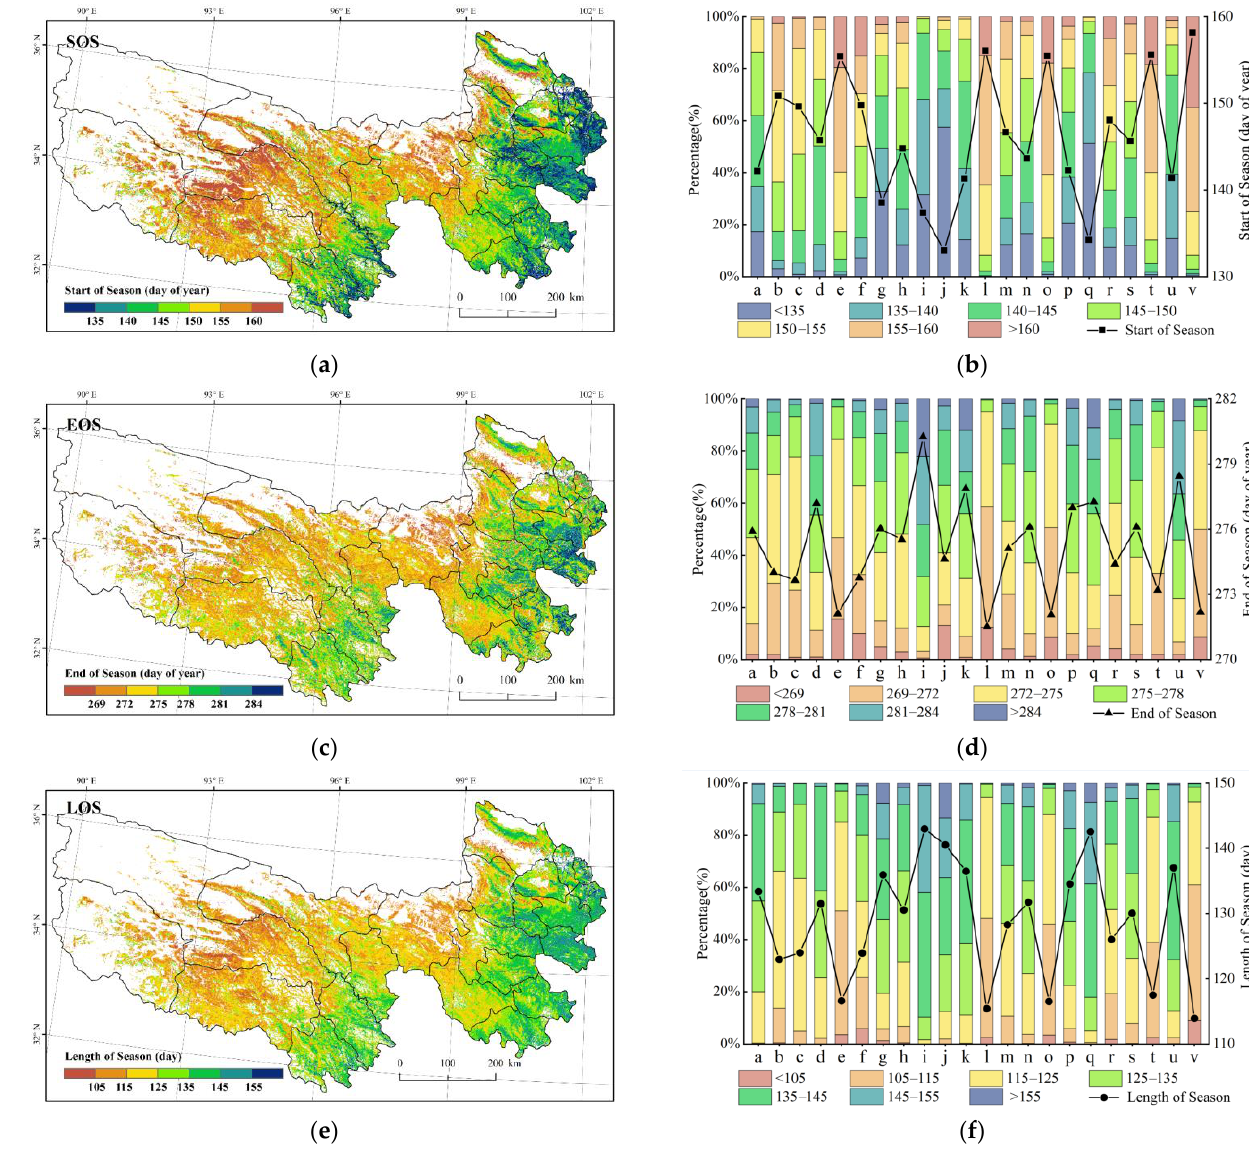
Figure 3. Spatial distribution and partition statistical diagram of the SOS (Start of Growing Season), EOS (End of Growing Season) and LOS (Length of Growing Season) of vegetation in the Three-River headwaters region. ( a ) Spatial distribution of the multi-year mean values of the vegetation SOS in the Three-River headwaters region. ( b ) Multi-year mean values of the vegetation SOS in the administrative regions of the Three-River headwaters region. ( c ) Spatial distribution of the multi-year mean values of the vegetation EOS in the Three-River headwaters region. ( d ) Multi-year mean values of the vegetation EOS in the administrative regions of the Three-River headwaters region. ( e ) Spatial distribution of the multi-year mean values of the vegetation LOS in the Three-River headwaters region. ( f ) Multi-year mean values of the vegetation LOS in the administrative regions of the Three-River headwaters region. Note: Horizontal coordinates a–v in ( b , d , f ) respectively represent a. Banma, b. Chengduo, c.